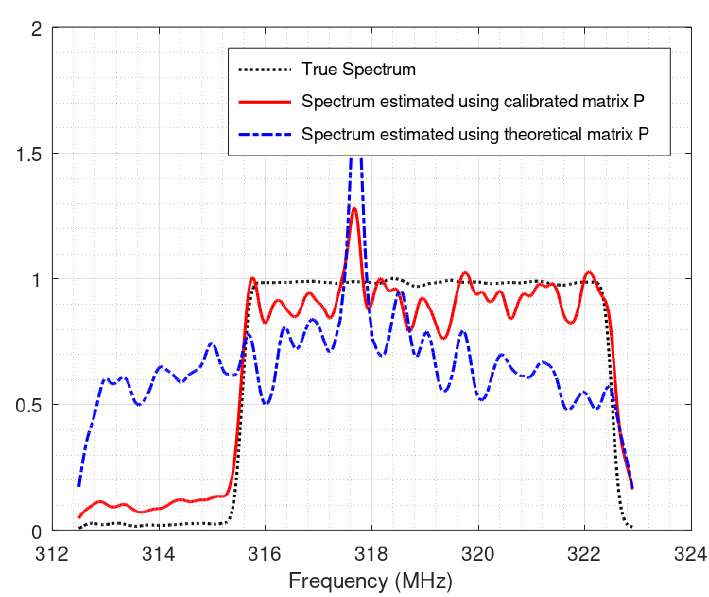
Figure 18. Example of sub-band spectrum reconstruction with and without